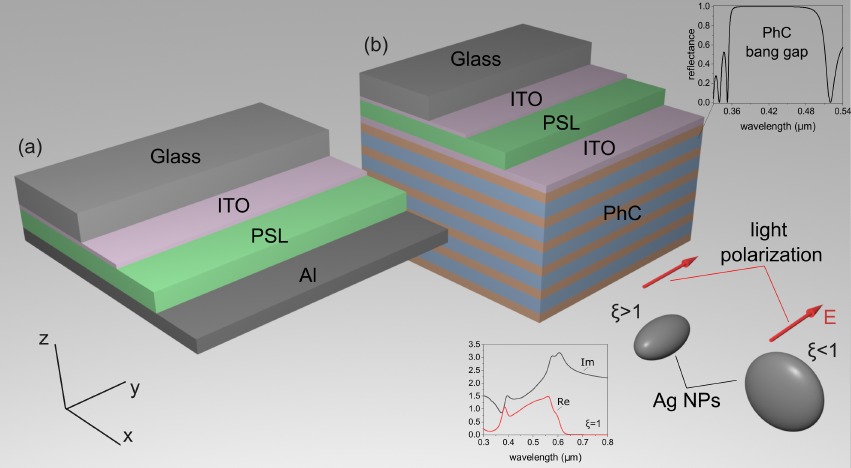
Figure 1. A sketch of the ( a ) conventional and ( b ) TPP-based solar cell. The red arrow shows the direction of the electric field of the incident wave (TM-wave). The direction of the vector perpendicular to the optical axis of the nanoparticles (along the x axis) corresponds to a TE-wave. The reflectance spectra of the bare PhC and real and imagenary parts of the PSL refractive index are shown in the